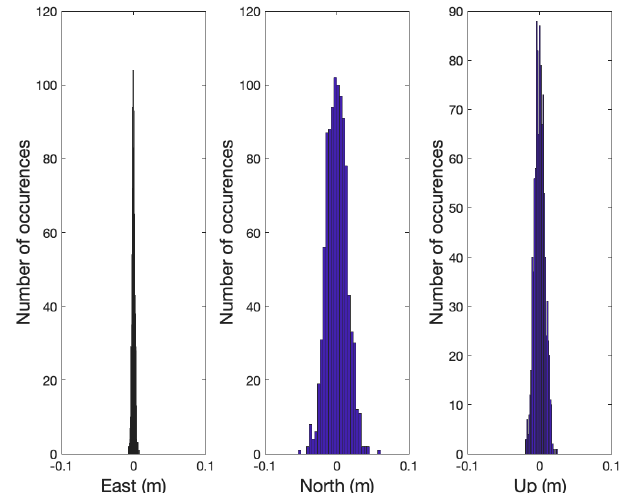
Figure 8. The figure shows the error distribution of the follower relative position, ˆ x MF , PAR , in ENU coordinates determined by the partially resolved integer ambiguities in 1000 simulation cases. The partial integer ambiguities were resolved at 16th epoch. ˆ x MF , PAR was computed by averaging the position solutions with the carrier phase measurements during 16 epochs and the partially resolved integer ambiguities.